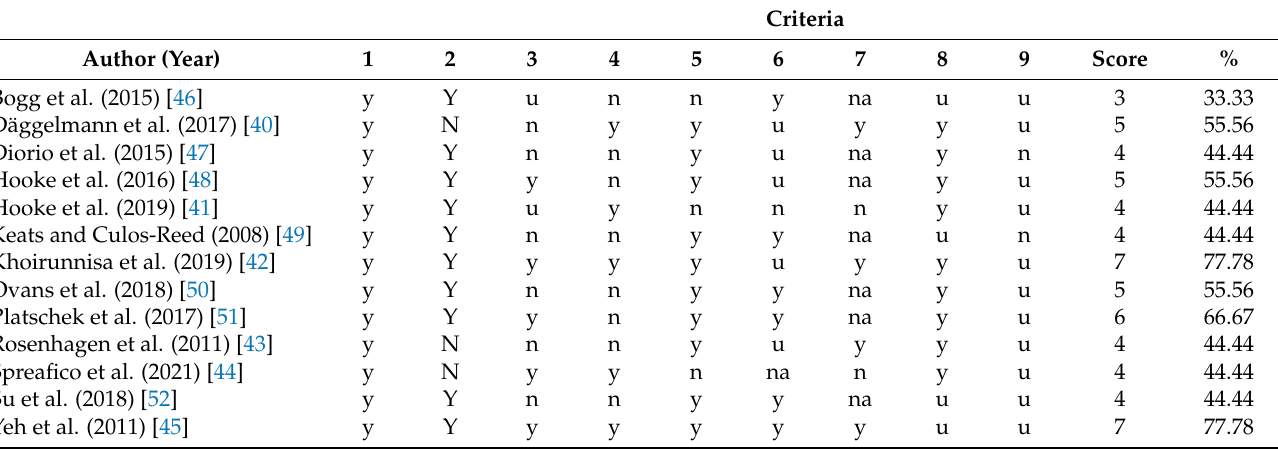
Table 4. Methodological quality of included QET and SGI.